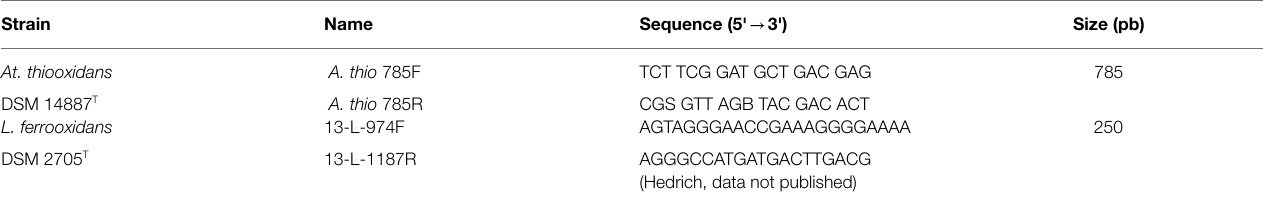
TABLE 1 | Designed primers for the quantification by qPCR of bacterial species of At. thiooxidans DSM 14887 T and L. ferrooxidans DSM 2705 T .